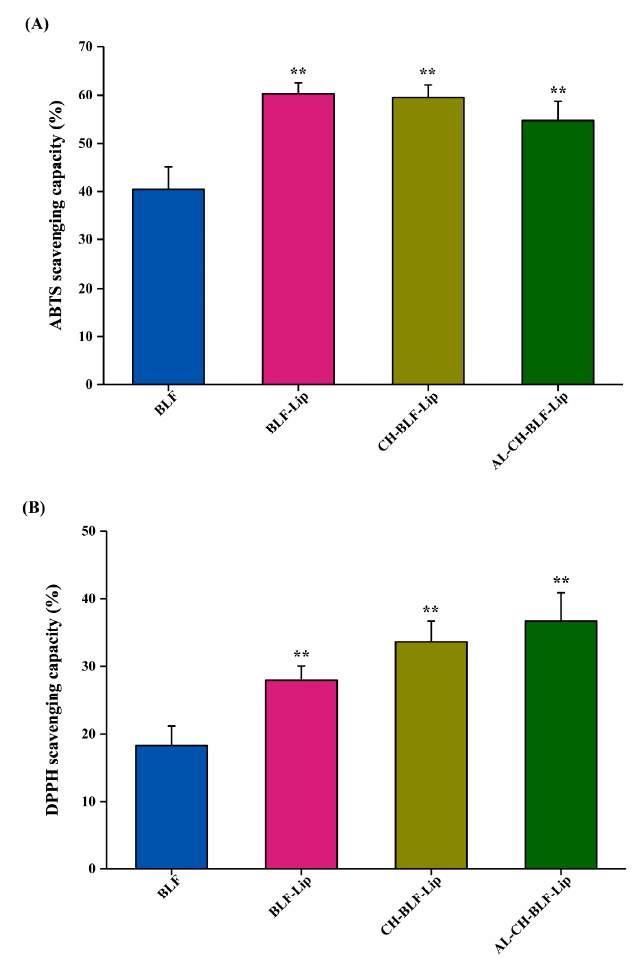
Figure 4. ( A ) ABTS radical scavenging capacity. ( B ) DPPH radical scavenging capacity. Data are presented as mean ± SD of three independent replications, ** p < 0.01 vs. BLF group. BLF, bamboo leaf flavonoids; BLF-Lip, BLF-loaded nanoliposomes; CH-BLF-Lip, BLF-loaded chitosan coated nanoliposomes; AL-CH-BLF-Lip, BLF-loaded alginate-chitosan coated nanoliposomes.